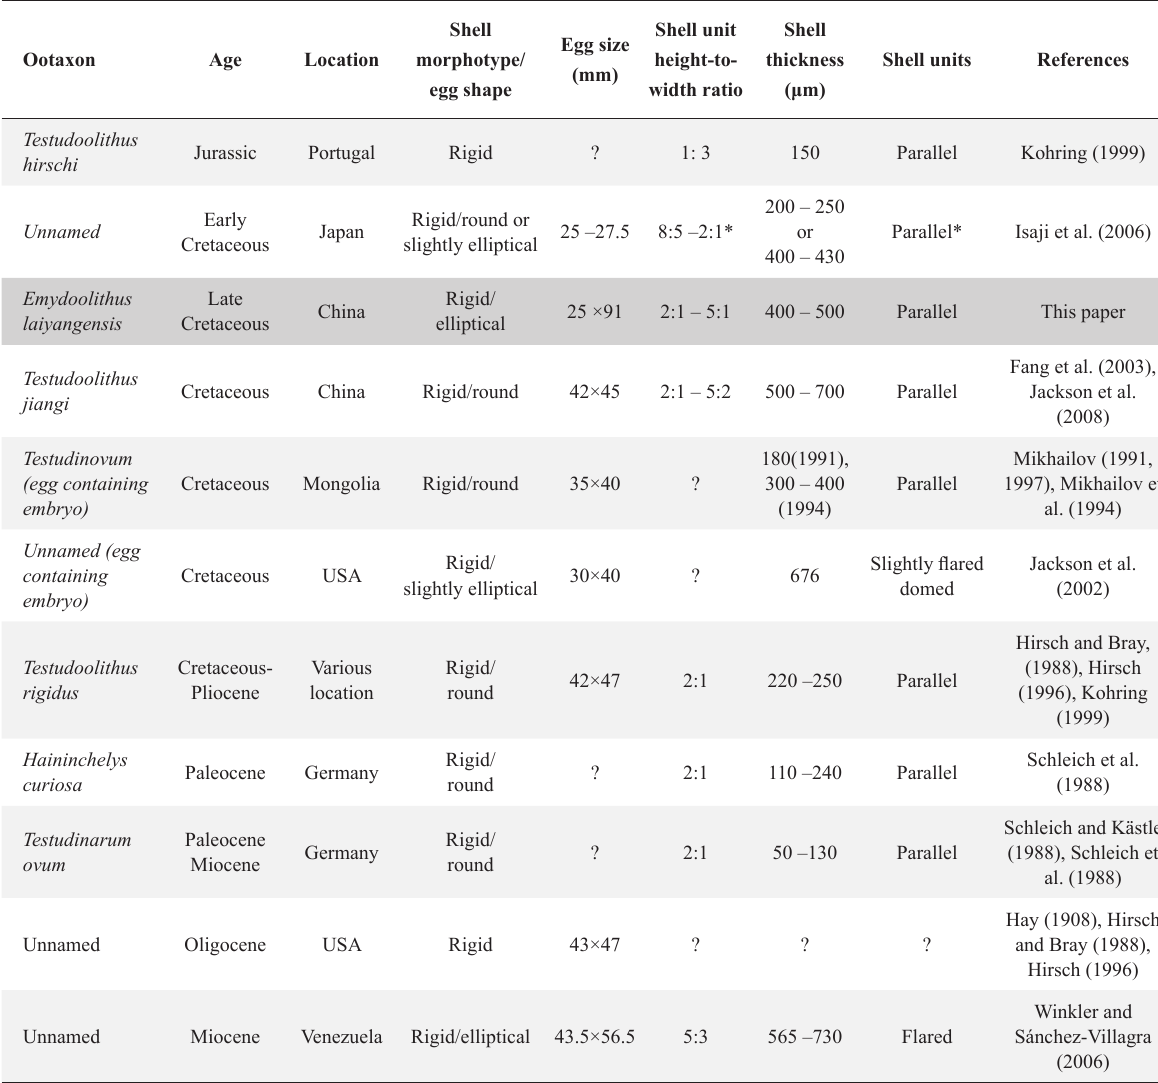
Comparison of chelonian eggs described here and other rigid-shell fossil turtle eggs and turtle egg ootaxa, arranged in chronological order (modified from Jackson et al. 2008 Table